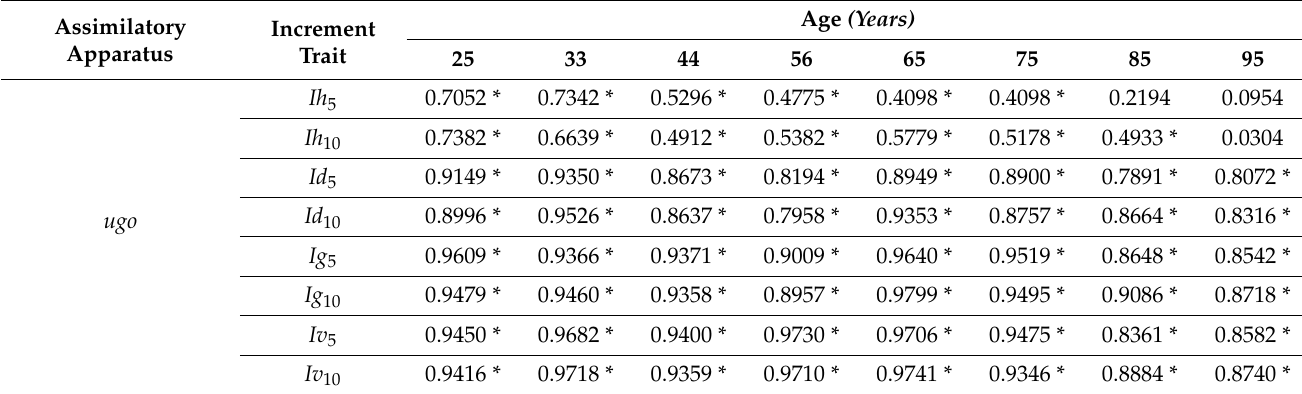
Table 9. Values of linear correlation coefficients r between the volume of leaved twigs ( ugo ) and increment traits ( Ih 5 , Ih 10 , Id 5 , Id 10 , Ig 5 , Ig 10 , Iv 5 , Iv 10 ) depending on the age of the stands.